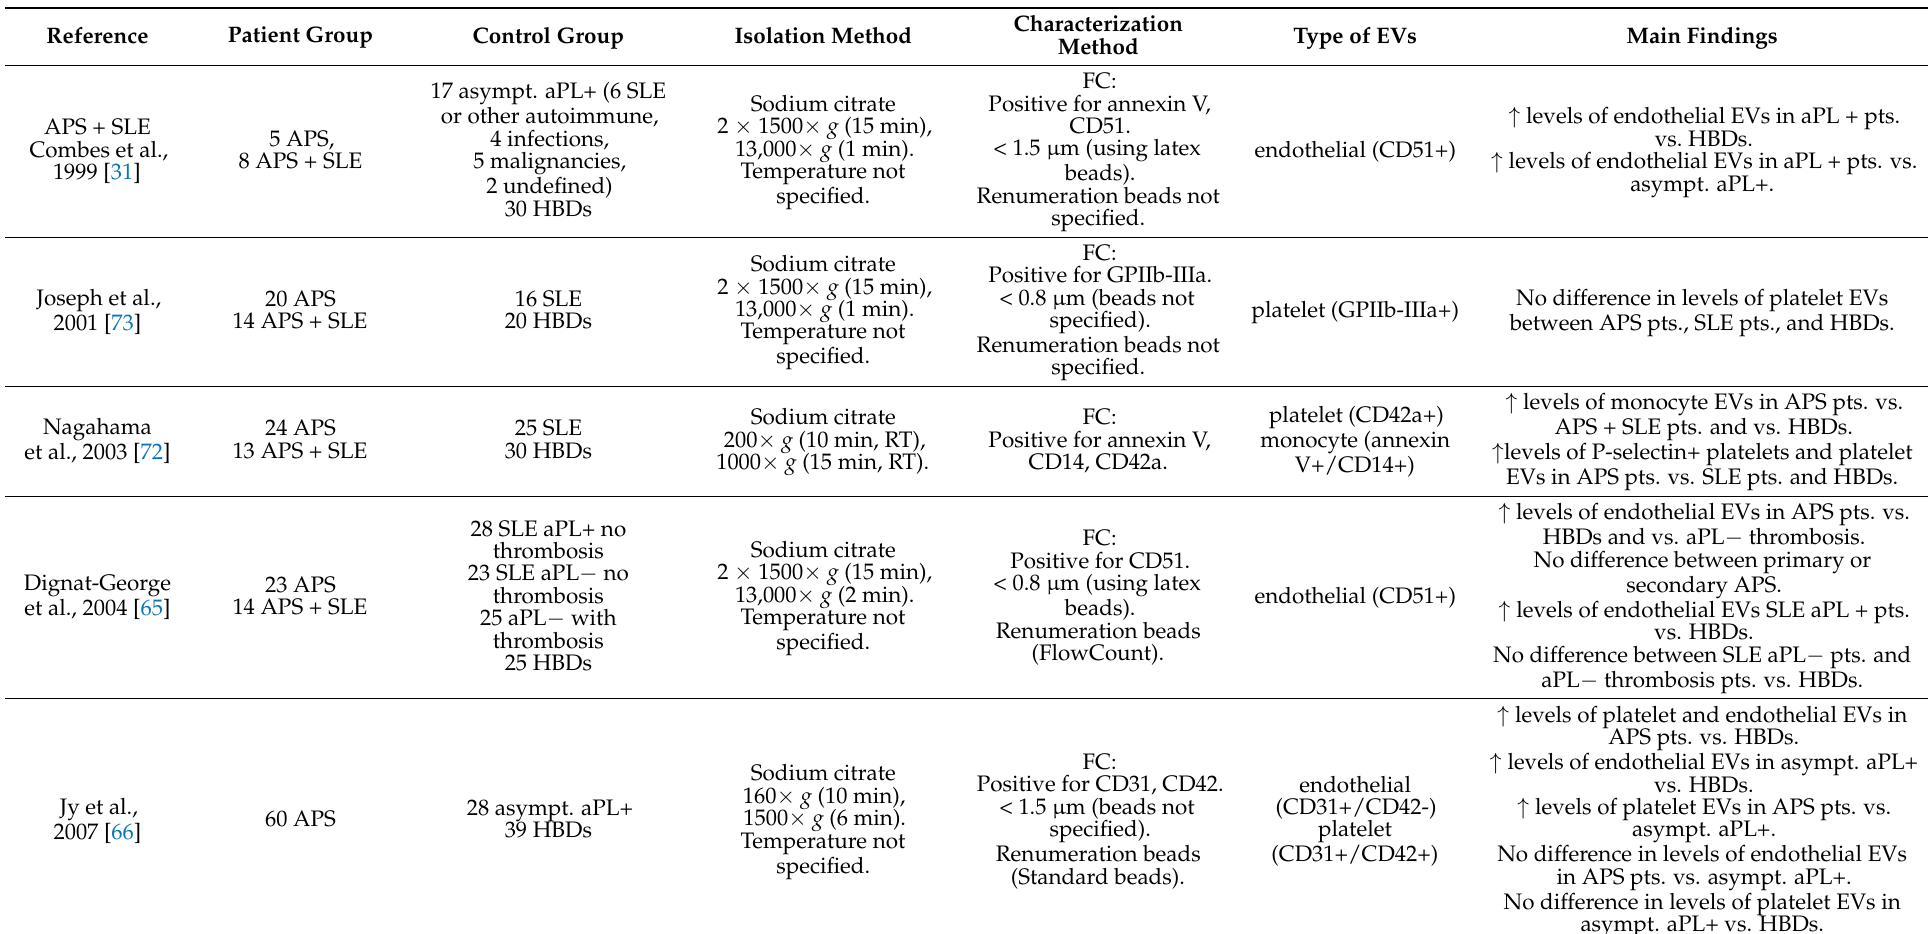
Table 1. Isolation, quantification and characterization of EVs in plasma of thrombotic APS